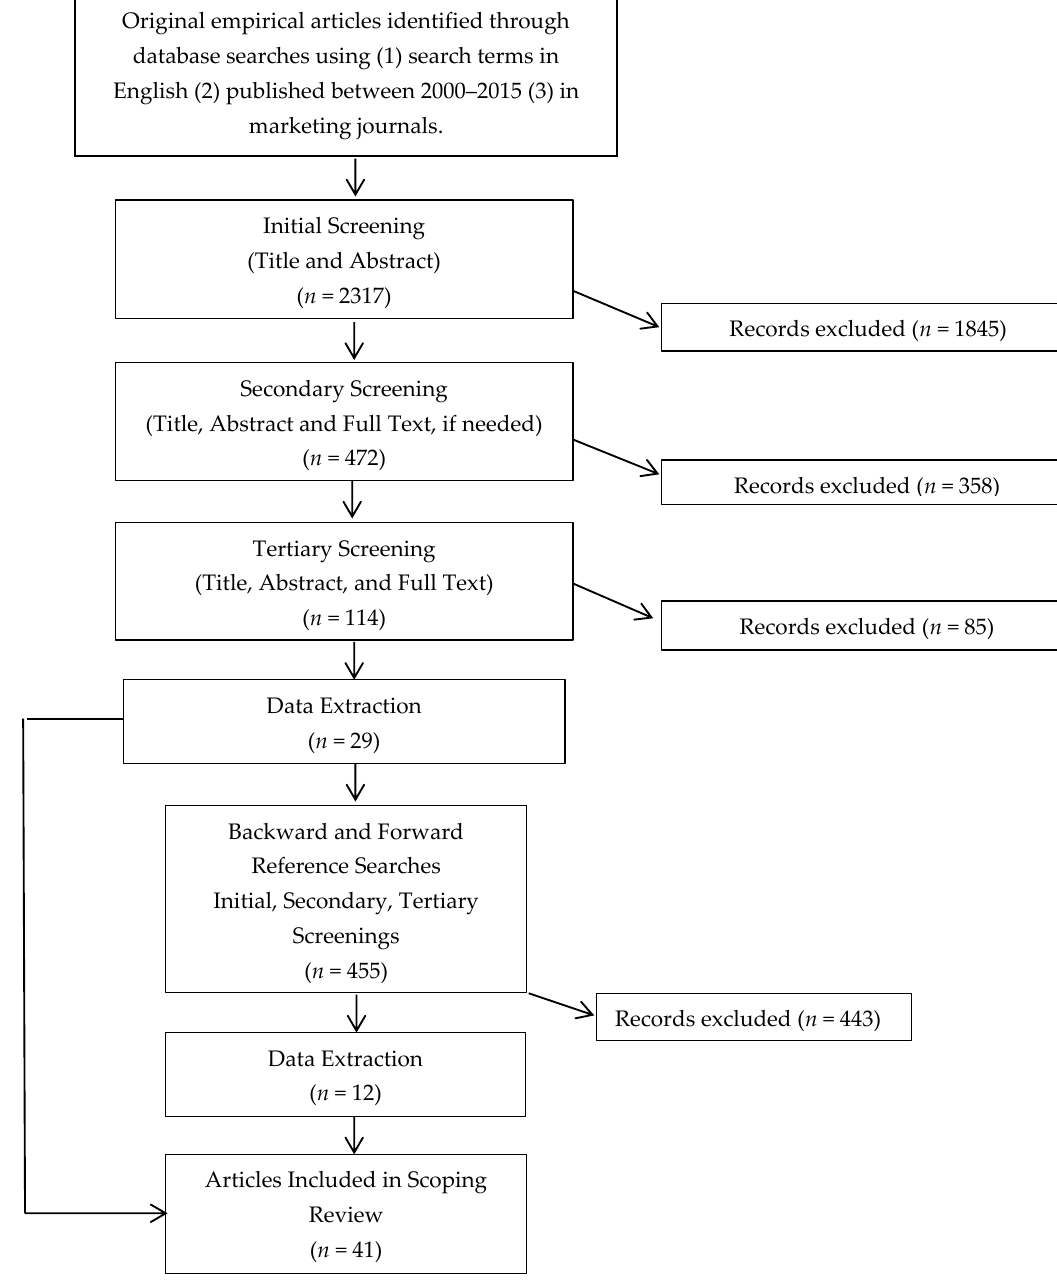
Figure 2. Article Inclusion Flow Chart.